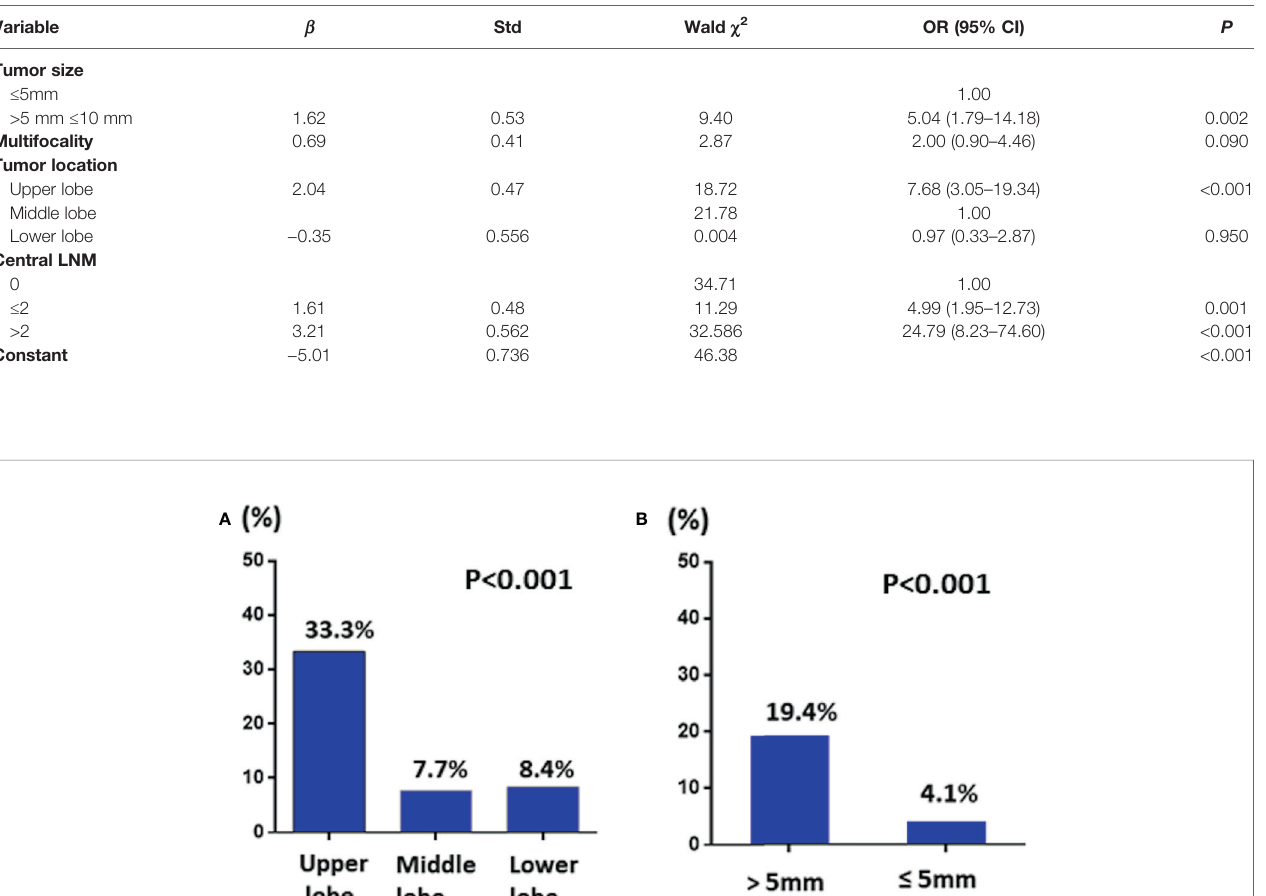
TABLE 3 | Multivariate analysis of factors related to lateral LNM in 345 patients with T1a